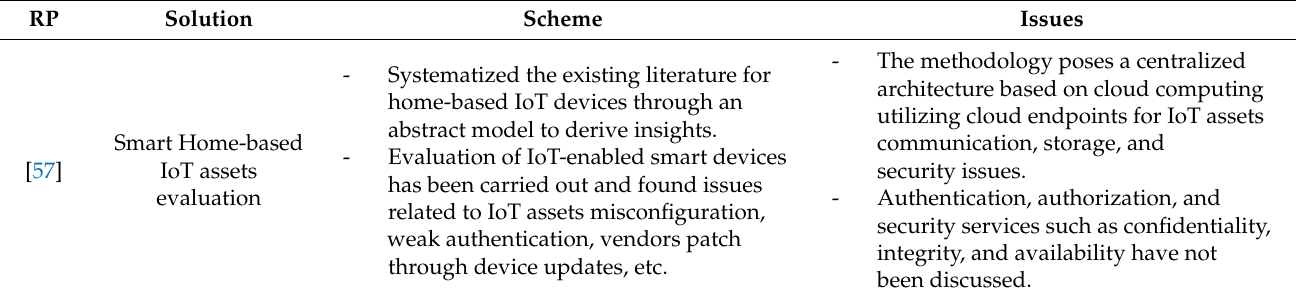
Table 1. IoT-Enabled Smart Device Authentication Schemes based on Centralized Architecture for Smart